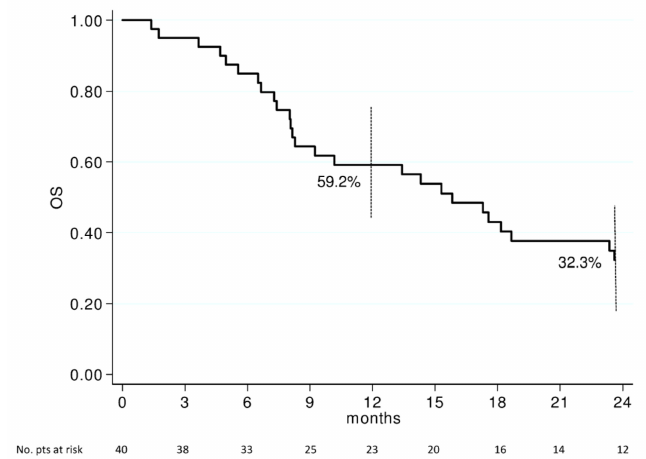
Figure 1. Overall survival of 40 patients with non-resectable locally advanced pancreatic cancer (LAPC). Vertical bars represent 95% Confidence Interval of survival probability at 1 and 2 years. OS: Overall Survival; pts: patients.